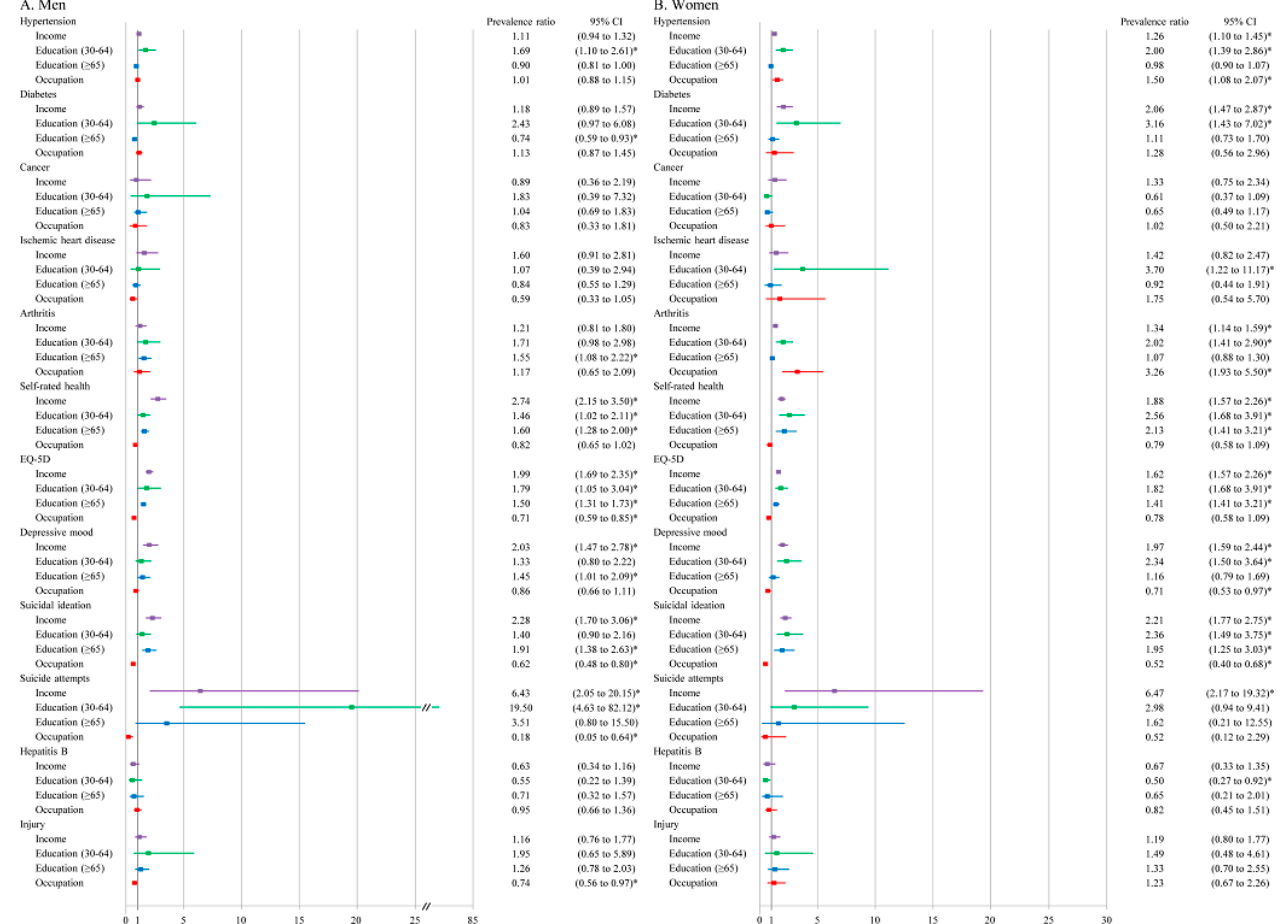
Figure 1. Age-adjusted prevalence ratios of 12 health problems in men ( A ) and women ( B ) according to income, education, and occupational groups in KNHANES 2010–2012. Notes: KNHANES = Korea National Health and Nutrition Examination Survey, EQ-5D = EuroQol five-dimension questionnaire. * denotes statistical significance at the 95% confidence level. †Reference categories of SEP measures are highest income quartile for income, college graduated and above for education of the middle aged (30–64), high school graduate and above for education of elderly people ( ≥ 65), and manager and office workers for occupational